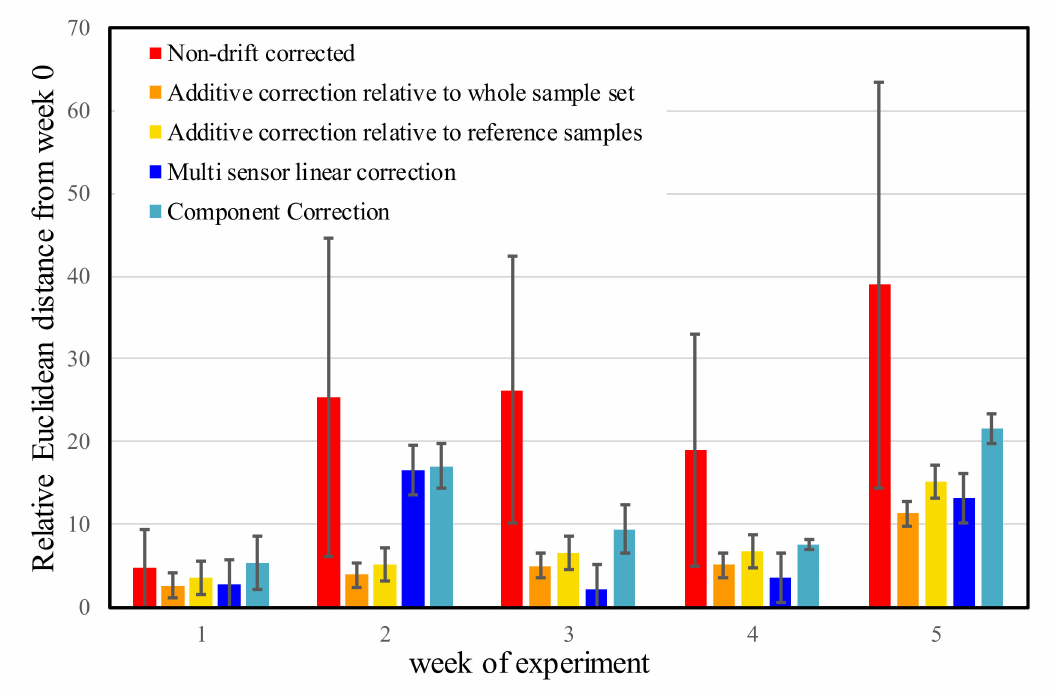
Figure 11. Comparison of the mean and standard deviation of the relative Euclidean distances of the apple juice samples from the center of week 0 calculated in the space of linear discriminant analysis models built based on the non-corrected and di ff erently drift corrected data of e-tongue measurements. The intervals show the variation in distance for the threefold linear discriminant analysis cross-validation